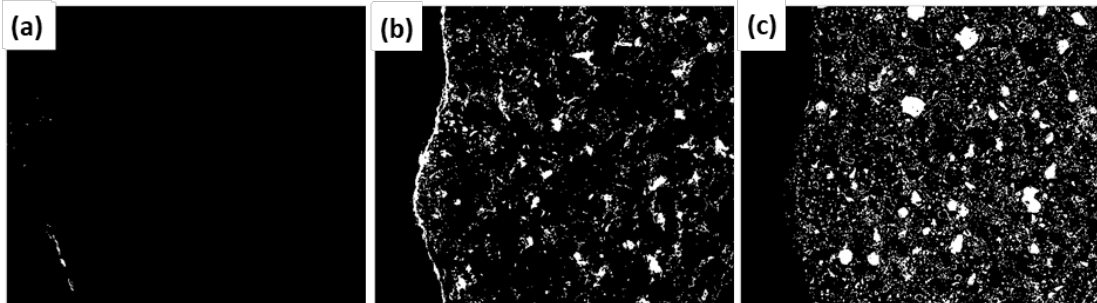
Figure 7. ( a ) Porosity of the aggregate, ( b ) porosity of the paste and ( c ) anhydrous material.